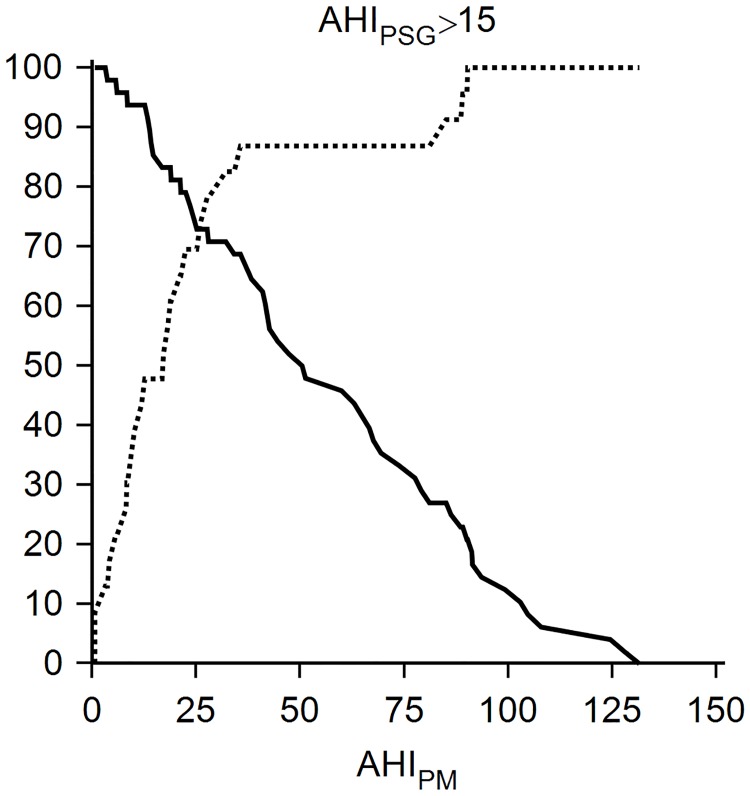
Plot versus criterion graph.This graph plots the sensitivity and specificity with 95% confidence intervals for different cutoff values of AHIPM; the criterion was AHIPSG ≥ 15.